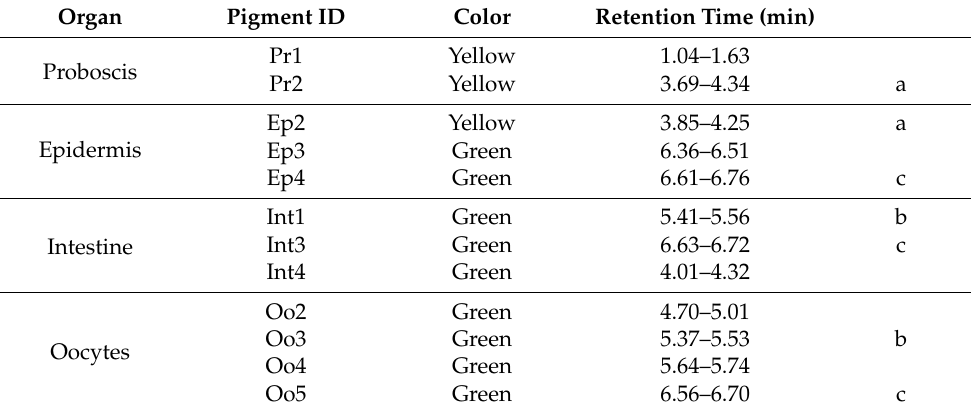
Figure 2. Common pigments between the different organs of Eulalia . The spectra were produced by high-performance liquid chromatography with a diode array detector (HPLC-DAD). ( a ) Yellow pigments Pr2 (proboscis) and Ep2 (epidermis); ( b ) Green pigments Int1 (intestine) and Oo3 (oocytes); ( c ) Green pigments Int3 (intestine), Oo5 (oocytes), and Ep4 (epidermis). Table 1. Summary of main pigments in Eulalia by organ. Each pigment was selected according to pigment absorption maxima. Retention time (min) corresponds to the timeframe within which the pigment was eluted from the HPLC column. Pigment color was determined by visual inspection and absorption at 400 nm (for yellow pigments) and 700 nm (for green pigments). Similar pigments are identified as a, b, or c (see Figure 2 as